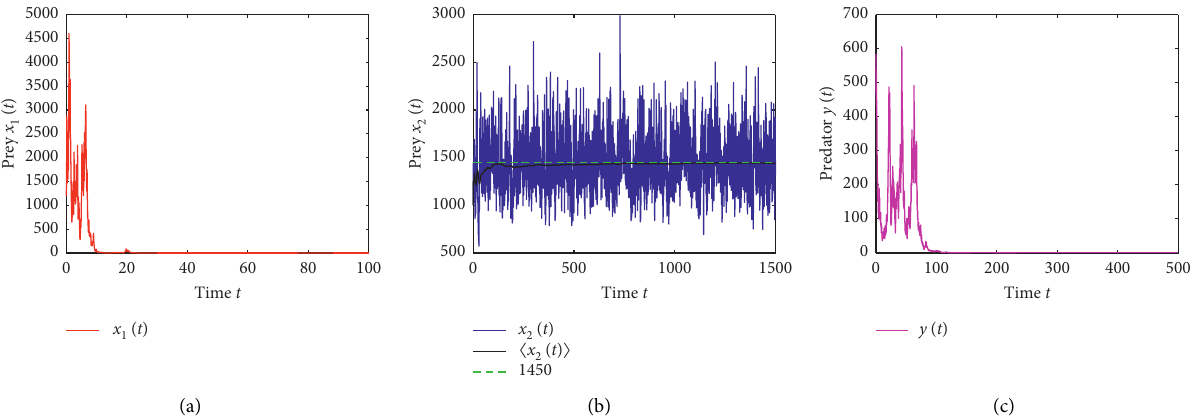
Figure 20: The trajectories of stochastic model (5) with σ 2 and (c) predator y ( t ) .